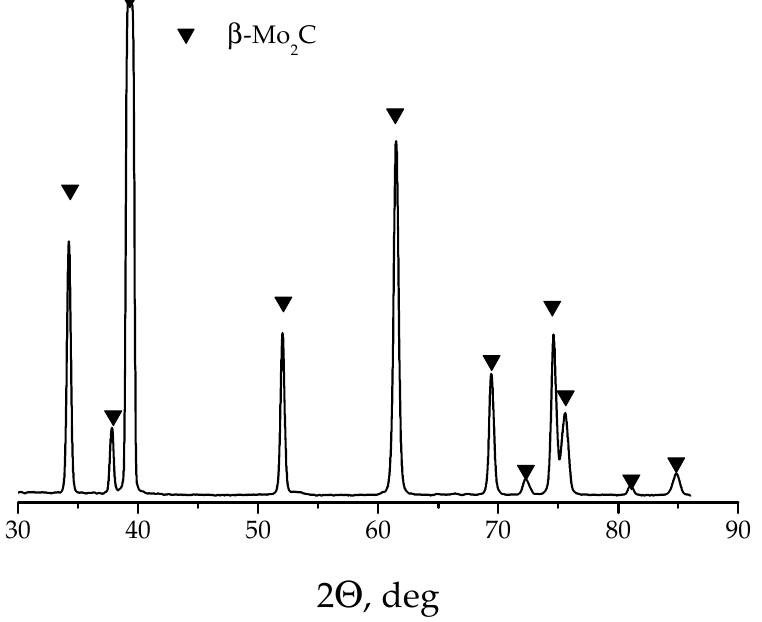
Figure 1. X-ray powder diffraction patterns of the molybdenum carbide coating on molybdenum substrates obtained at 1123 K and a current density of 5 mA cm − 2 from the NaCl-KCl-Li 2 CO 3 (1.5 wt.%)-Na 2 MoO 4 (8.0 wt.%) melt (solid line), data points indicate the reference sample.